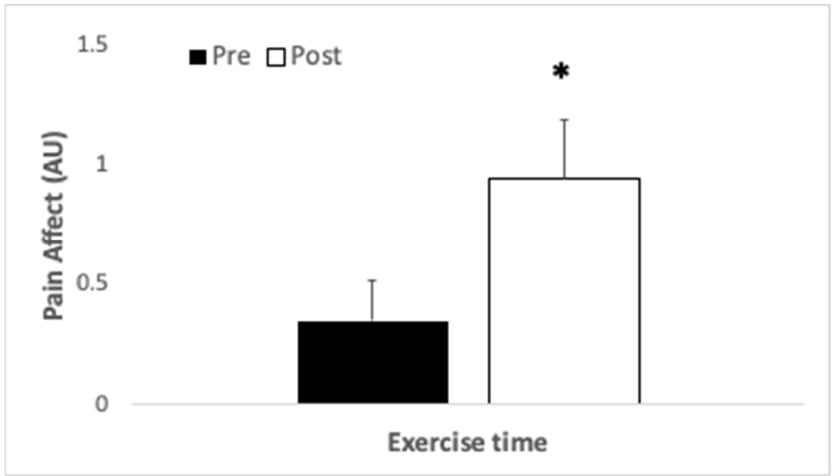
Figure 5. Pain affect (arbitrary units), perceived by participants ( N = 20) who completed an uphill hike as quickly as possible after consumption of β -alanine or placebo prior to immersion in nature. * indicates significant difference between times sampled.